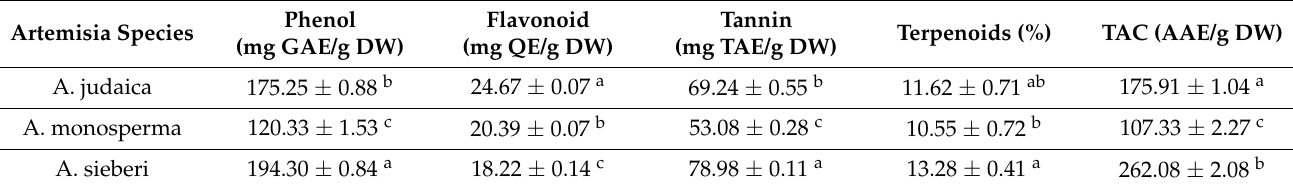
Table 2. Total phenol, total flavonoids, total tannin content, terpenoids, and TCA of Artemisia species.